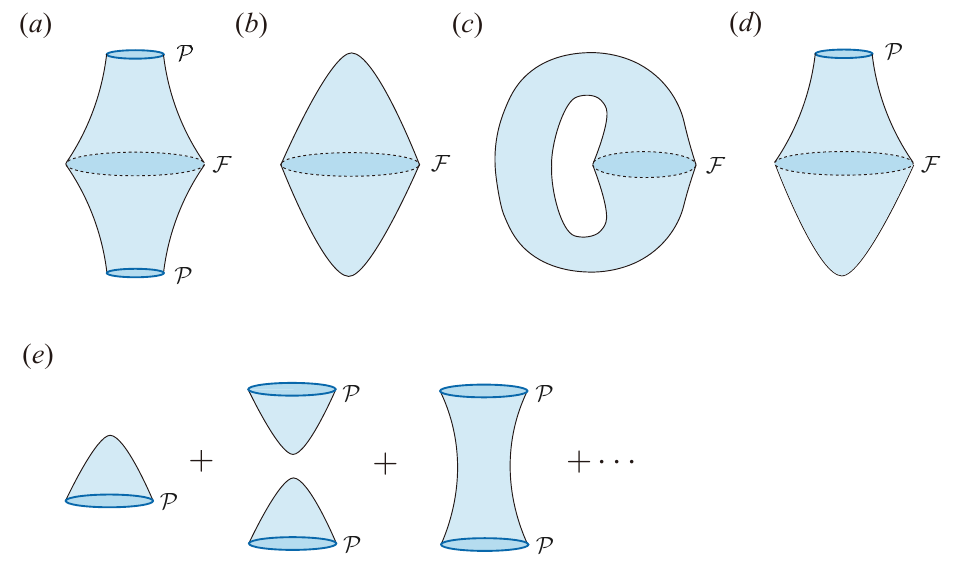
Figure 6 . Geometries that appear in the computation of the overlap h C | C i . ( a ): spacetime initiated by the EOW brane. ( b ): Hartle-Hawking no-boundary state. ( c ): bra-ket wormhole. ( d ): off-diagonal overlap of spacetime initiated by the EOW brane and no-boundary state. ( d ): geometries completely disconnected from F which only contribute to the overall constant of h C | C i